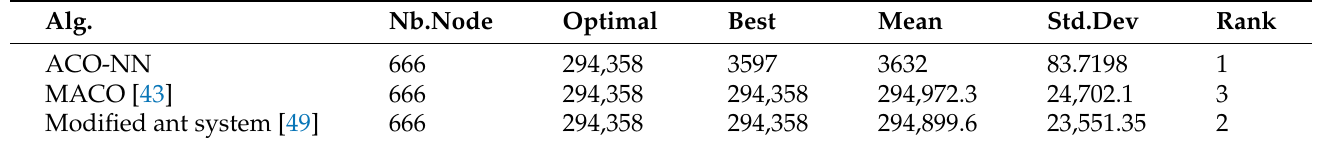
Table 3. Comparison of ACO-NN to MACO and modified ant system for Gr666.